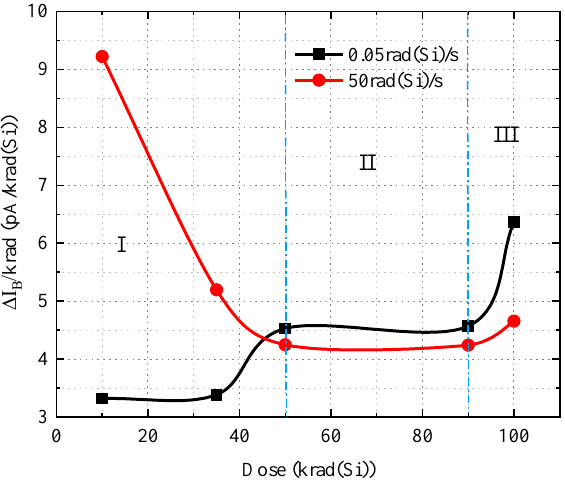
Figure 5. The degradation rate of the excess base current of a DPSA BJT under di ff erent dose